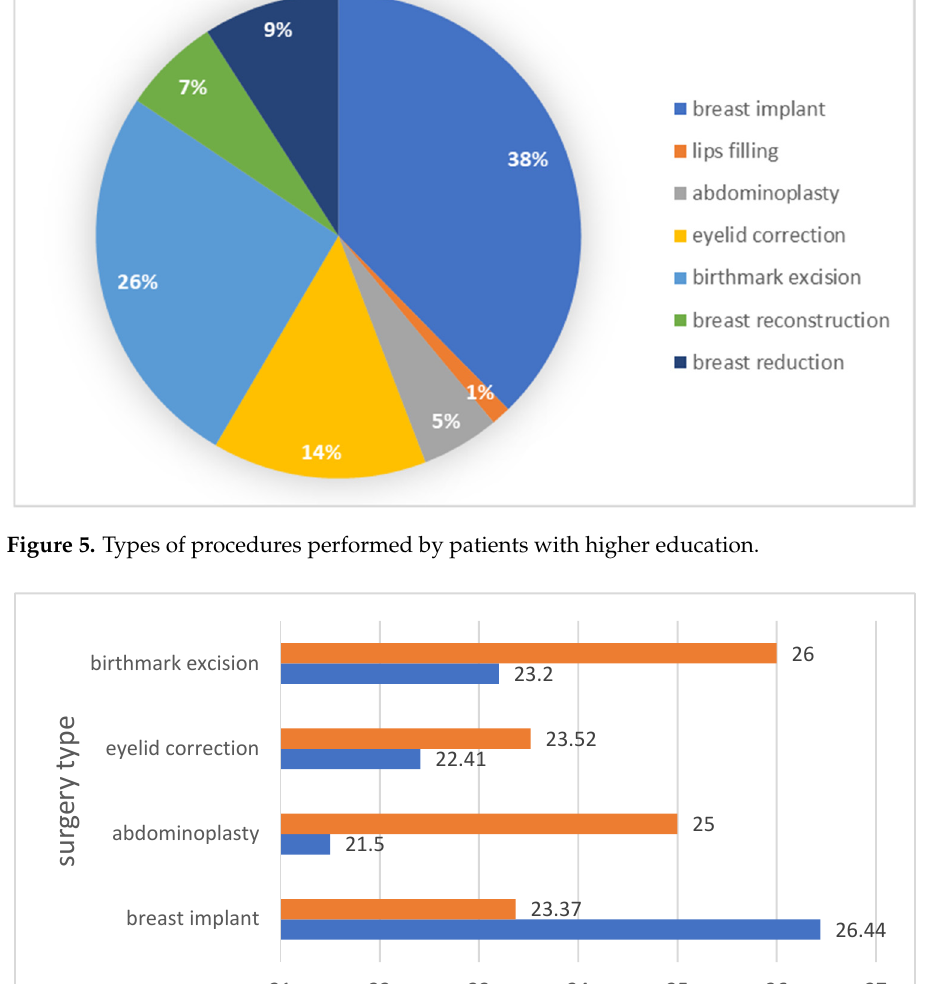
Figure 5. Types of procedures performed by patients with higher education.